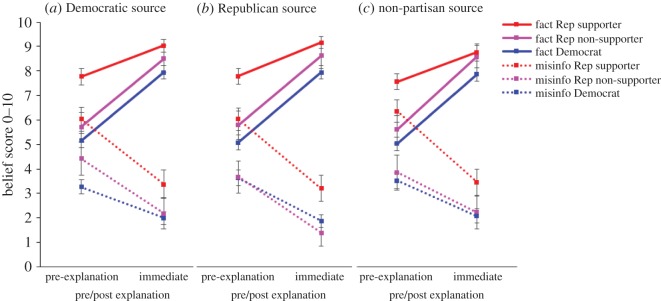
(a–c) Belief in Trump misinformation and facts after partisan explanations. Rep, Republican; Misinfo, misinformation. Dotted lines show misinformation items. Error bars denote 95% confidence intervals.